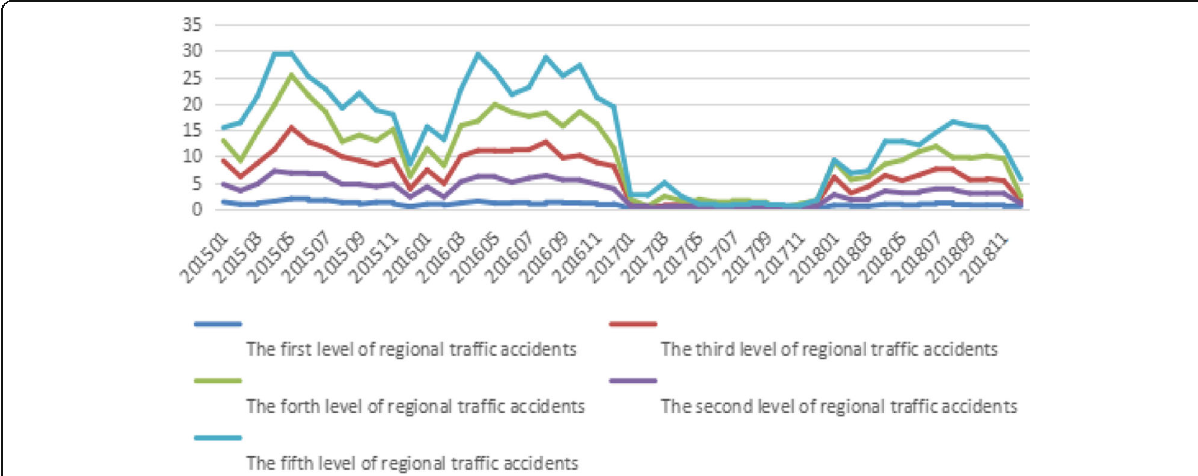
Fig. 8 Average spatial incidence level of various traffic accidents